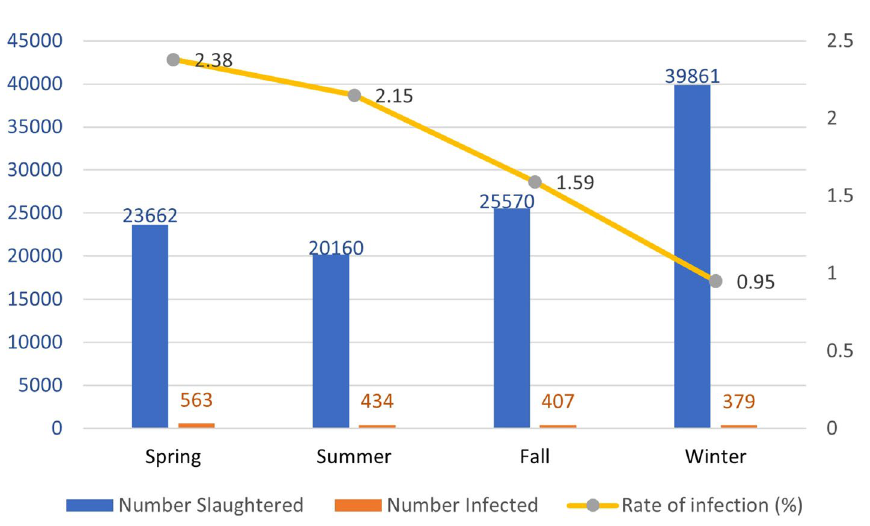
Figure 2. Correlation between seasons and rate of